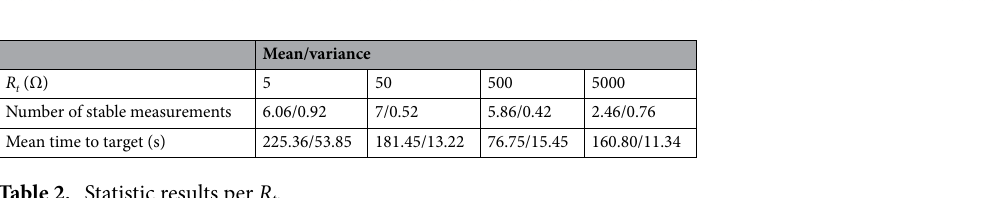
Table 2. Statistic results per R t